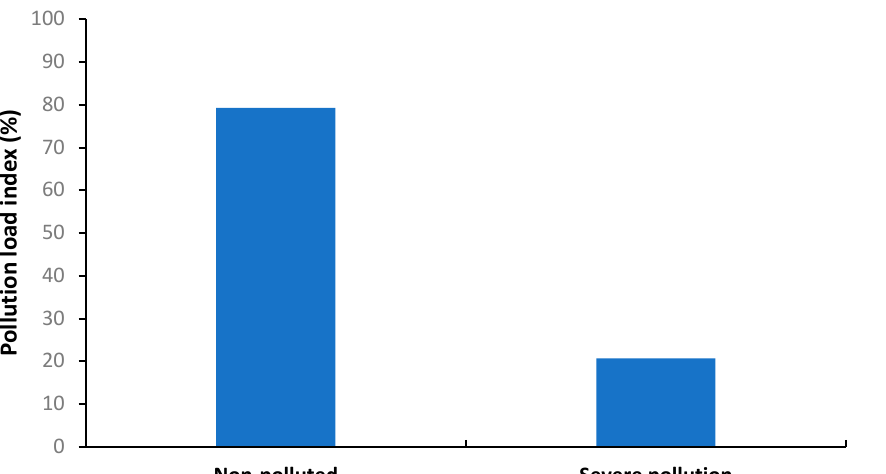
Figure 3. Distribution of the market gardens of Lubumbashi according to the enrichment factors.